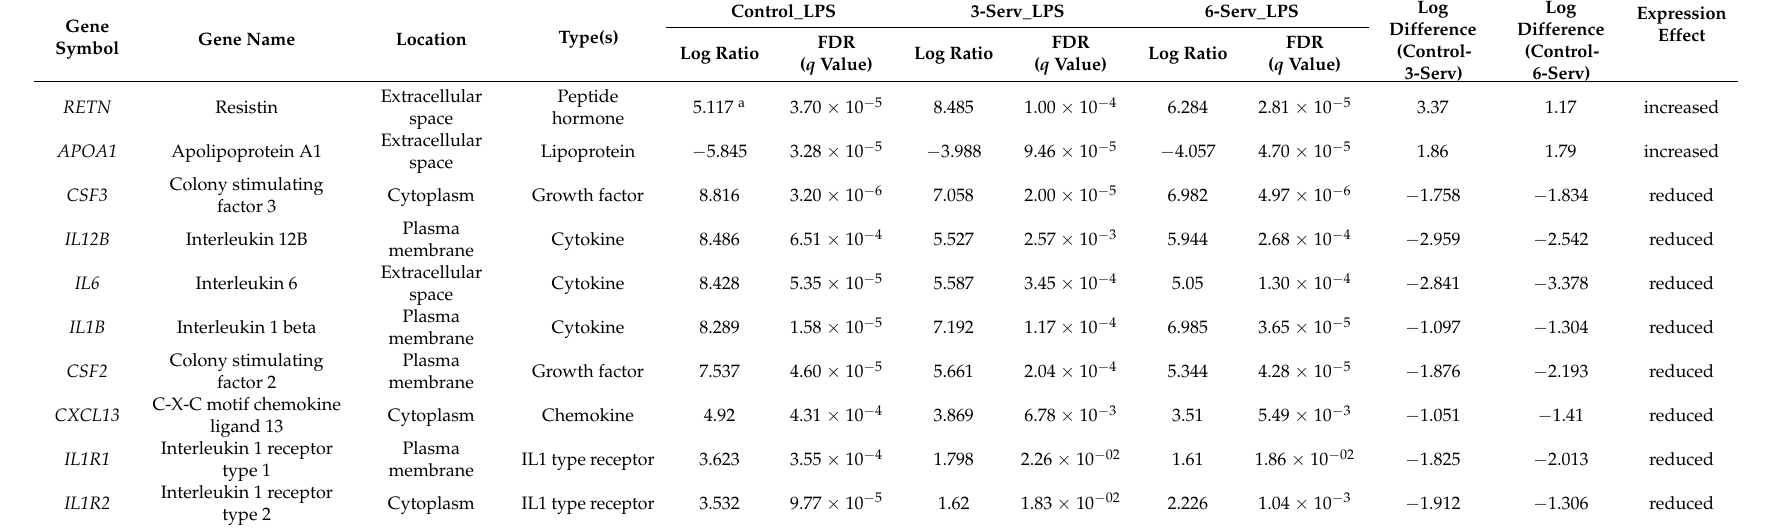
Table 2. Top differentially expressed genes in alveolar macrophages (AM) after Salmonella typhymurium LPS